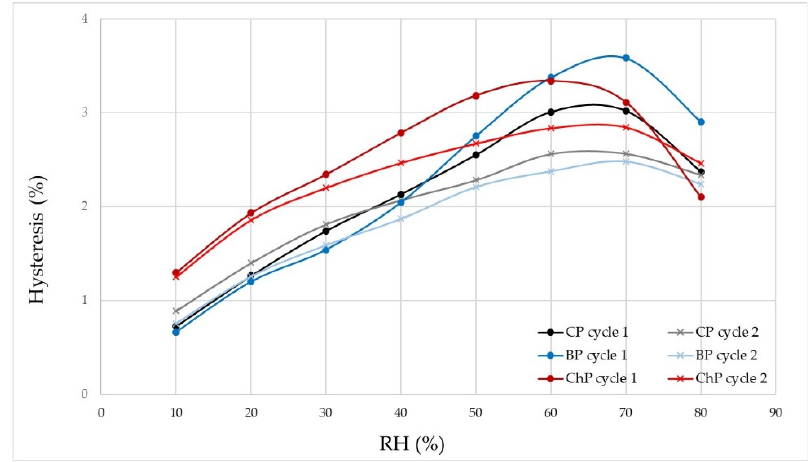
Figure 2. Water sorption hysteresis (for undegraded and degraded pine wood); ads—adsorption,